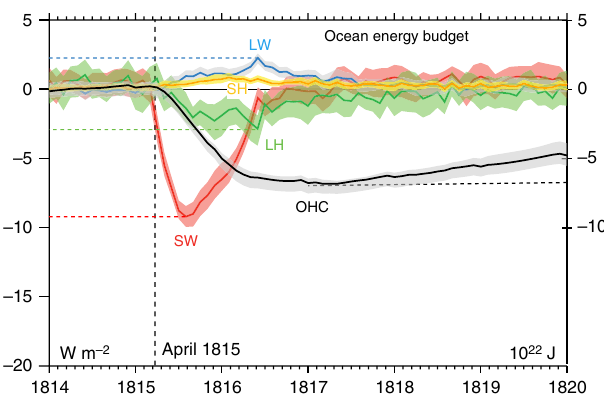
Fig. 5 Responses in terms of the surface energy budget and OHC to the 1815 eruption. Changes in terms of the surface energy budget over ocean (left axis) following the 1815 Mt. Tambora eruption including net upwelling longwave fl ux (LW), sensible heat (SH), latent heat (LH), and net surface shortwave absorption (SW). Also shown is the change in full-depth OHC (right